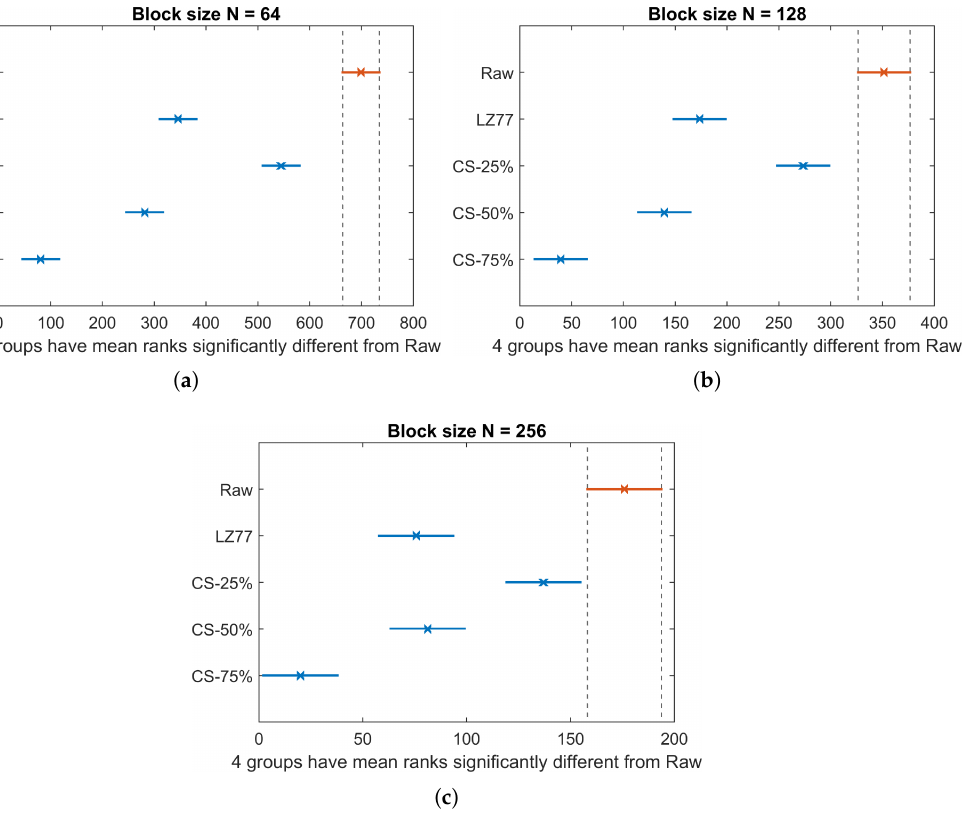
Figure 14. TEC Kruskal–Wallis mean ranks and Dunn comparison intervals for different compression types: ( a ) N = 64; ( b ) N = 128; and ( c ) N =